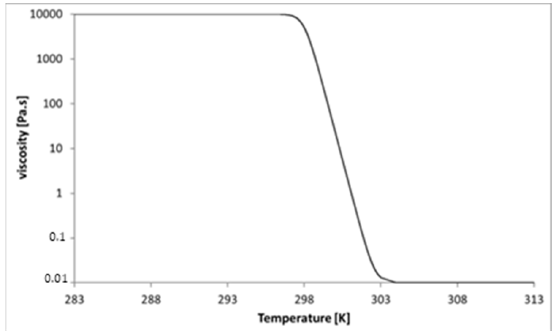
Figure 4. Dynamic viscosity of used PCM.